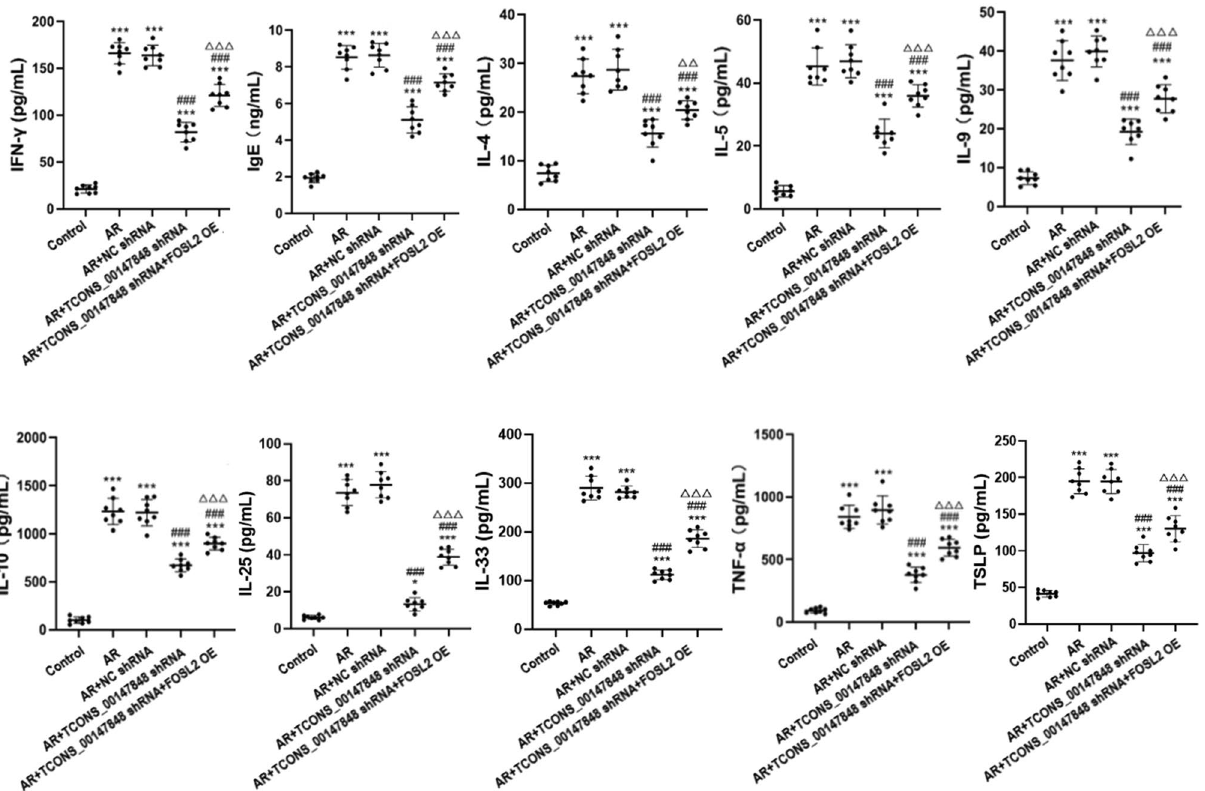
Figure 3. TCONS_00147848 and FOSL2 regulated expressions of IgE, IL-4, IL-5, IL-9, IL-10, IL-25, IL-33, TSLP, IFN-γ and TNF-α detected by ELISA in mice. * P < 0.05 vs. Control group, *** P < 0.001 vs. Control group, ### P < 0.001 vs. AR group, △△ P < 0.01 vs. AR + TCONS_00147848 shRNA group, △△△ P < 0.001 vs. AR + TCONS_00147848 shRNA group (Software version: SPSS 23.0; URL: https:// www. ibm. com/ legal/ copyt rade.